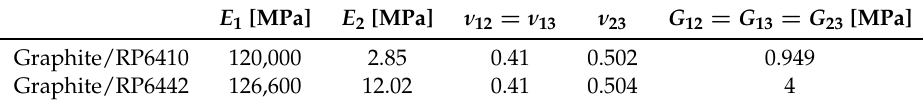
Table 3. Mechanical properties of: Graphite/RP6410 and Graphite/RP6442 [64]. E 1